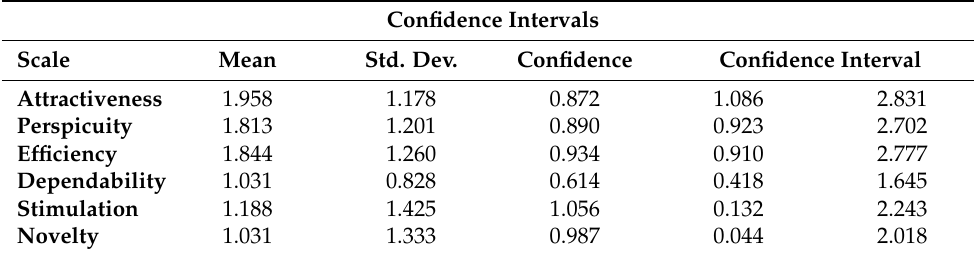
Table 3. ACUX-R confidence intervals per